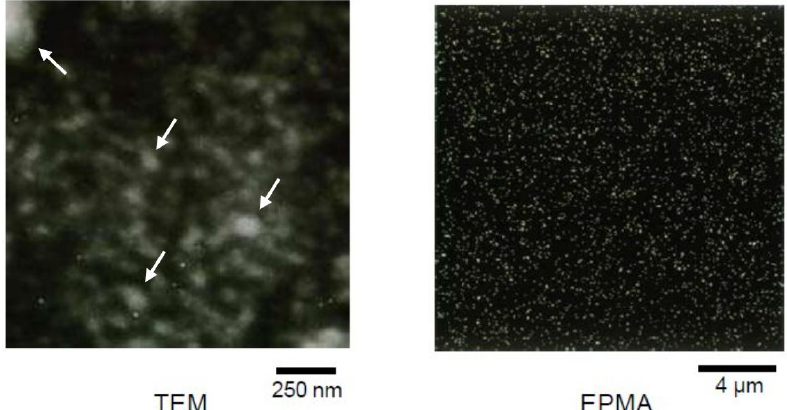
Figure 3. TEM and EPMA images of ESO/POSS-1 nanocomposite (90:10